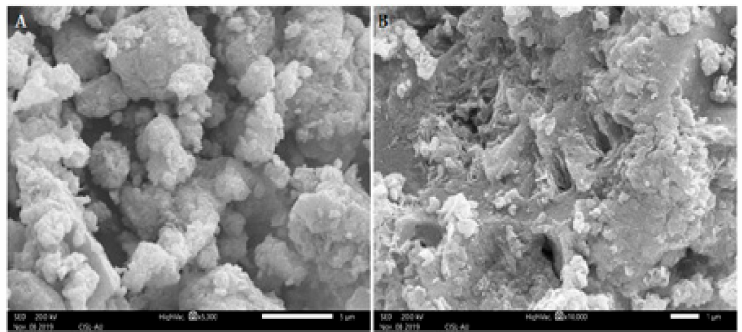
Figure 4. SEM images of zinc nanoparticles synthesized using Eucalyptus globules leaf extract. Bar scale—5 µ m ( A ) and 1 µ m ( B